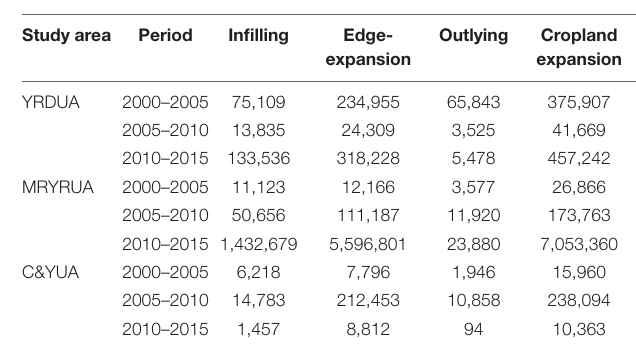
TABLE 1 | Areas of different cropland expansion trajectories in 2000–2015 in YRDUA, MRYRUA, and C&YUA